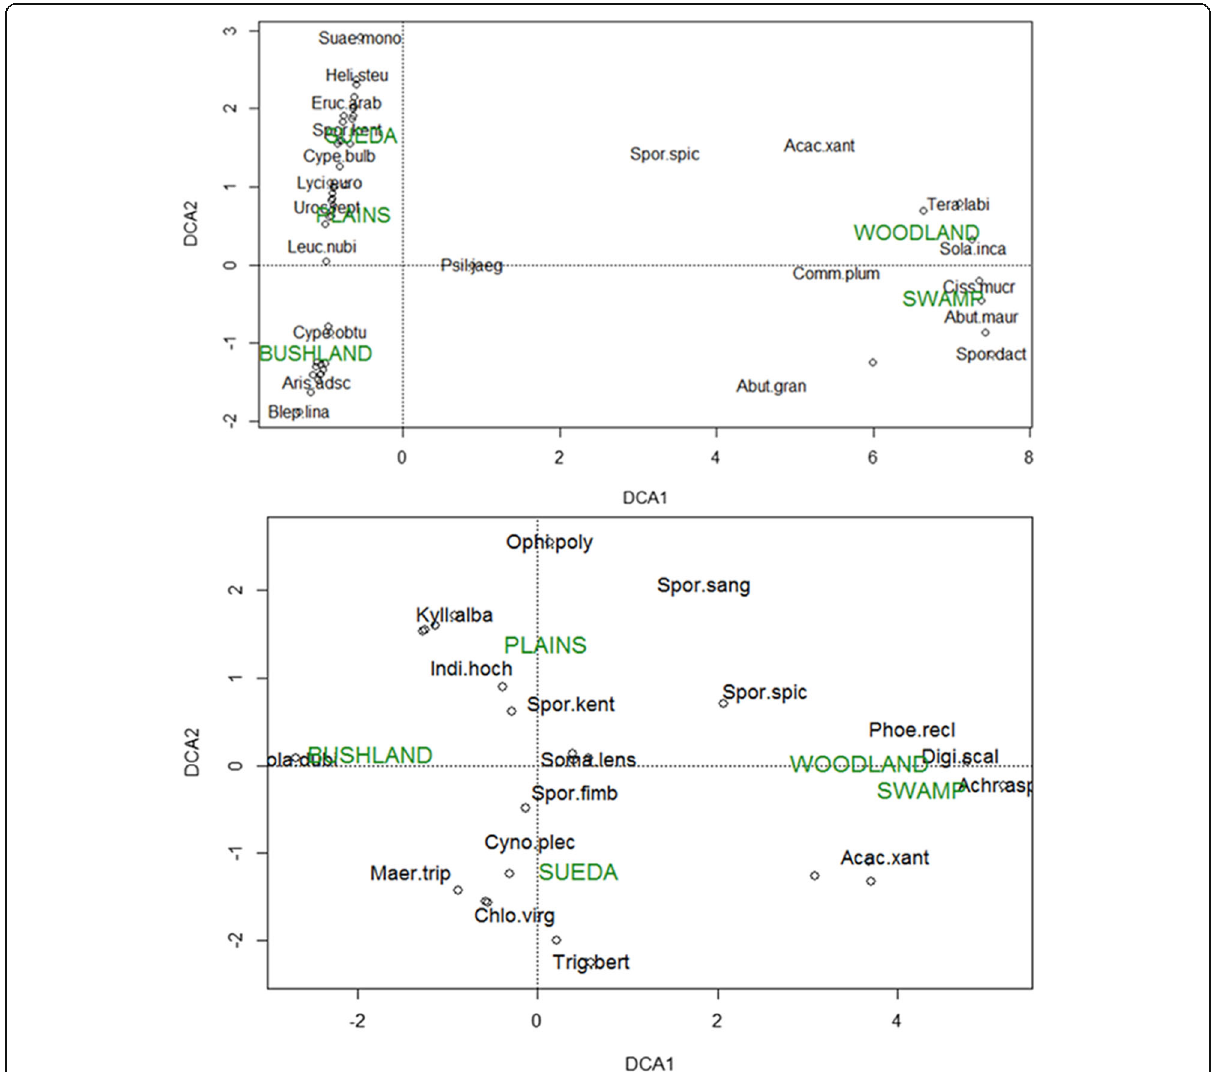
Fig. 5 Detrended correspondence analysis ordination shows the increasing similarity in species composition among habitats between the 1970s (top) and 2010s (below). The names shown in the figures are the first four letters of the genus and species names. The complete species list is provided in Table